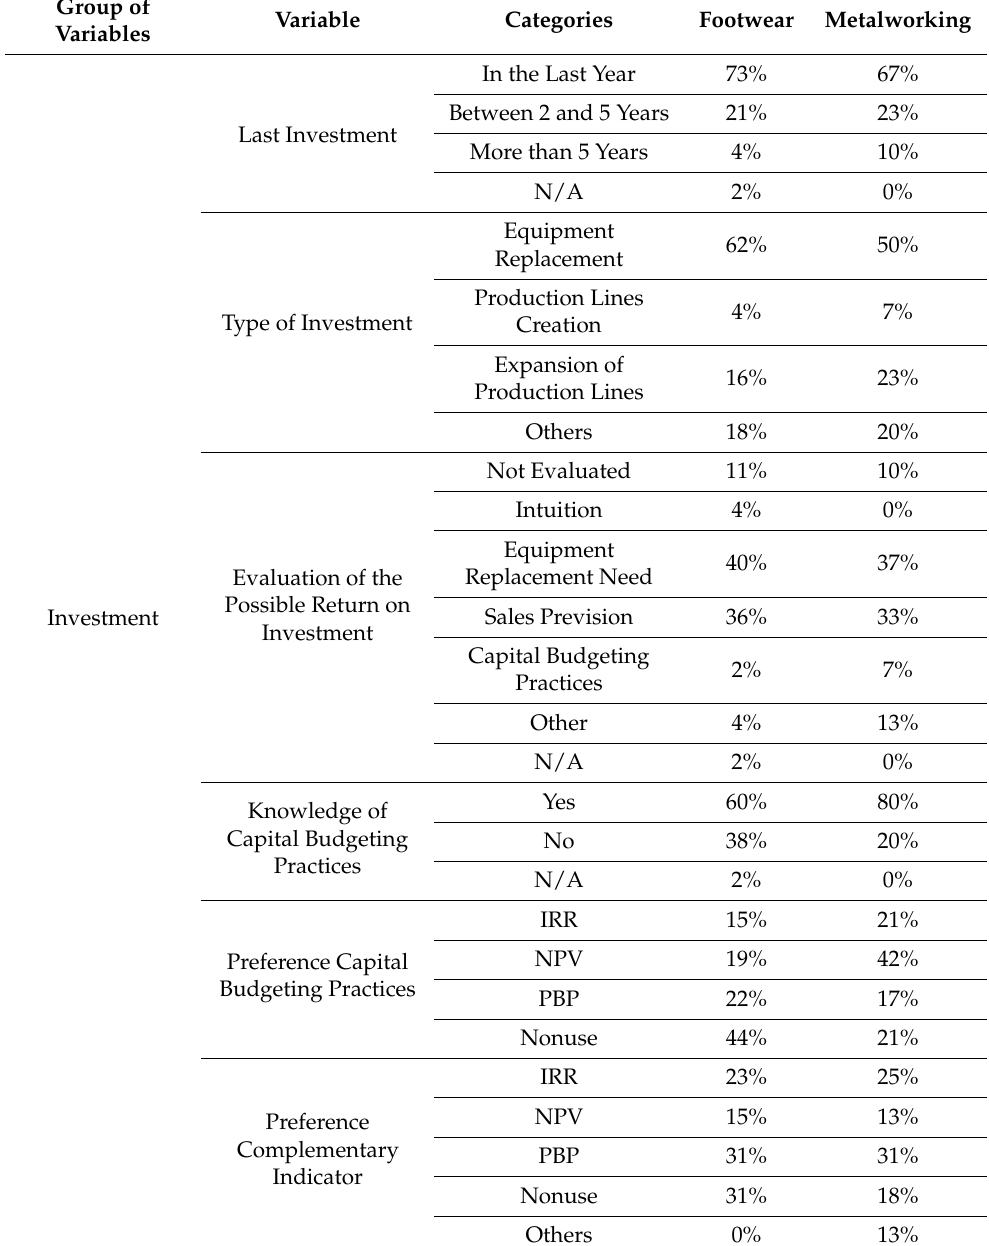
Table 3. Descriptive characteristics of the investment-related